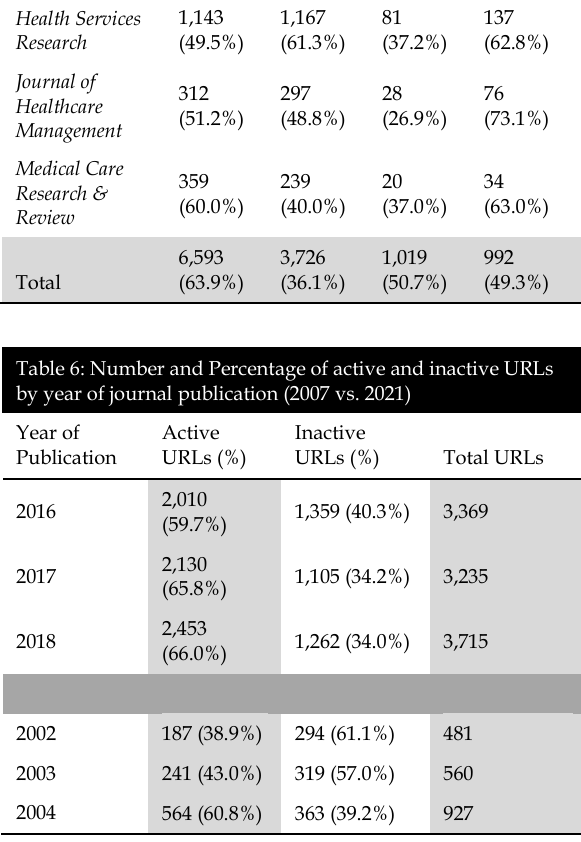
Table 7: Number and Percentage of active and inactive URLs by top-level domain (2007 vs. 2021)